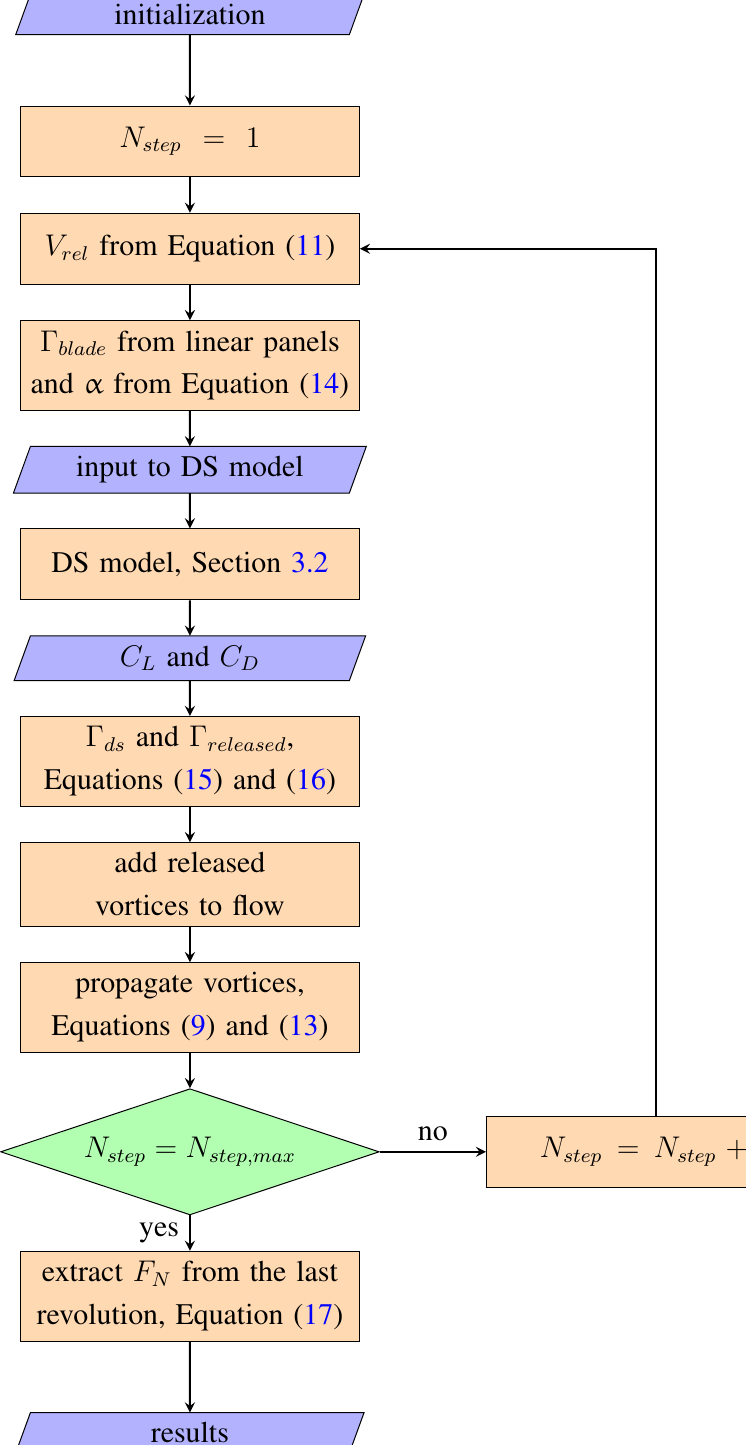
Figure 6. Flow chart of the vortex model combined with the dynamic stall (DS) model. N is the current time step, and N step N = 12 , 000 , corresponding to 120 time steps per each of 100 step,max